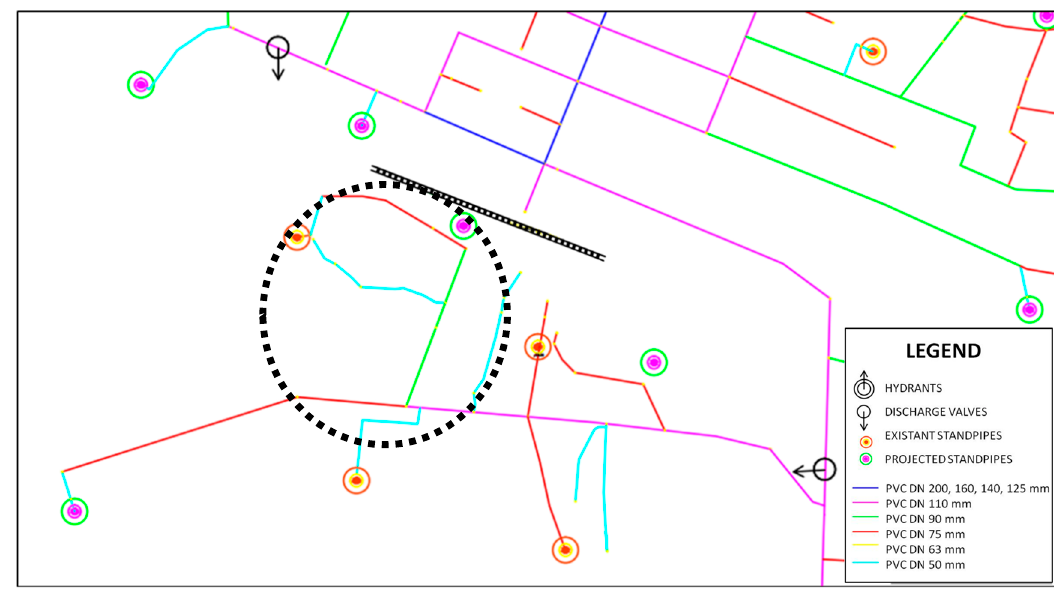
Figure 3. Detail of the shape and layout of the water distribution network in Bairro Central in design map 2011. (Source: Collins Sistemas de Agua Lda.).